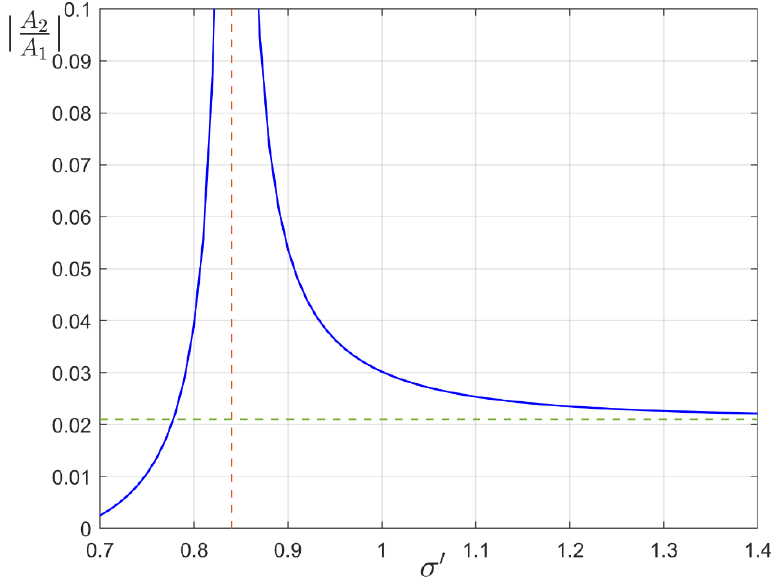
Figure 4. The plot of the ratio 𝐴 2 (𝑧′, 𝜎′)/𝐴 1 (𝑧′, 𝜎′) coefficients to 𝜎′ at 𝑧′ = 1 .